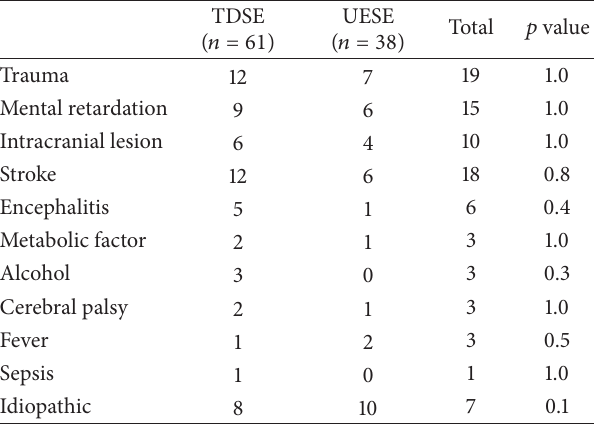
Table 5: Causes of status epilepticus ( 𝑛 = 99